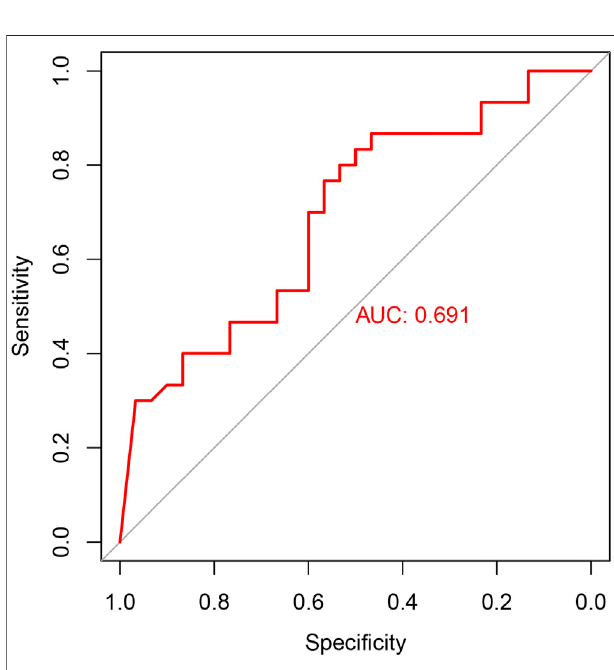
FIGURE 12 | ROC curve in the validation